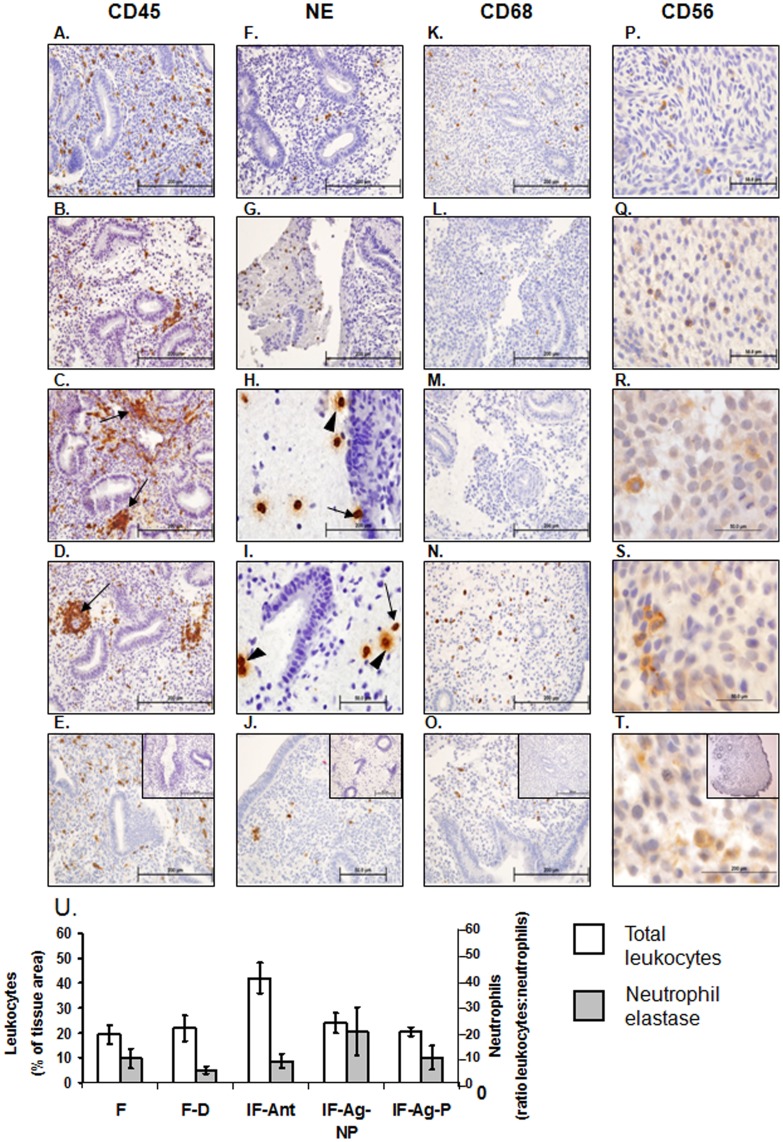
Leukocyte immunohistochemistry and semi quantitative analysis.Immunohistochemical staining was performed to examine the localization leukocyte subtypes (CD45/leukocyte common antigen, A-E), neutrophils (neutrophil elastase, F-J), macrophages (CD68, K-O) and uterine natural killer cells (CD56, P-R). In fertile endometria at LH+2 leukocytes are scattered throughout the tissue (A). At hCG+2 in stimulated endometria from fertile donor women undergoing GnRH agonist stimulation (B), infertile women undergoing GnRH antagonist stimulation (C) and infertile women undergoing GnRH agonist stimulation who did not become pregnant (D) clusters of leukocytes can be observed particularly adjacent to endometrial glands and surrounding blood vessels (B, C, and D, arrows). In endometria of women stimulated with the GnRH agonist protocol who subsequently became pregnant at hCG+2 (E) leukocytes are found scattered throughout the tissue, similar to that observed in fertile women at LH+2 (A). Very few neutrophils can be observed in the endometria of fertile women at LH+2 (F) or fertile women undergoing GnRH agonist stimulation for ovum donation at hCG+2 (G). In stimulated endometria from GnRH antagonist stimulated infertile women (H) or GnRH agonist protocol who did not become pregnant (I) numerous neutrophils can be observed particularly within mucous like areas and to a lesser degree within the tissue. Many of these are degranulating (H & I, closed arrowhead). Very few neutrophils were evident in the endometria of GnRH agonist stimulated infertile women who became pregnant (J). Scattered macrophages could be observed in endometria of fertile women at LH+2 (K). Very few macrophages were present in fertile women undergoing GnRH agonist stimulation for ovum donation (L) or infertile women undergoing GnRH antagonist stimulation (M). Scattered macrophages were observed in the endometria of infertile women stimulated with the GnRH agonist protocol whether they did not (N) or subsequently achieved (O) pregnancy. Few uterine natural killer cells were detected at LH+2 (P) or hCG+2 in endometria of fertile (Q) infertile women stimulated with the GnRH antagonist protocol (R), or the GnRH agonist protocol who did not (S) or did (T) become pregnant at hCG+2. IgG controls are shown inset in panels E, J, O and T. Scale bars are shown in each image, all 200 µm except P - T at 50 µm. Semi quantitative scoring of total leukocyte numbers (U) revealed increased leukocyte numbers in endometria of infertile women stimulated with the GnRH antagonist protocol at hCG+2 compared with fertile women at LH+2 (U, white bars, P<0.05). No significant differences in neutrophil numbers were observed (U, grey bars). F = fertile, IF = infertile, F–D = fertile donor, IF-Ant = infertile antagonist, IF-Ag-NP = infertile agonist non-pregnant, IF-Ag-P = infertile agonist pregnant. Data are expressed as mean ± SEM, *P<0.05.